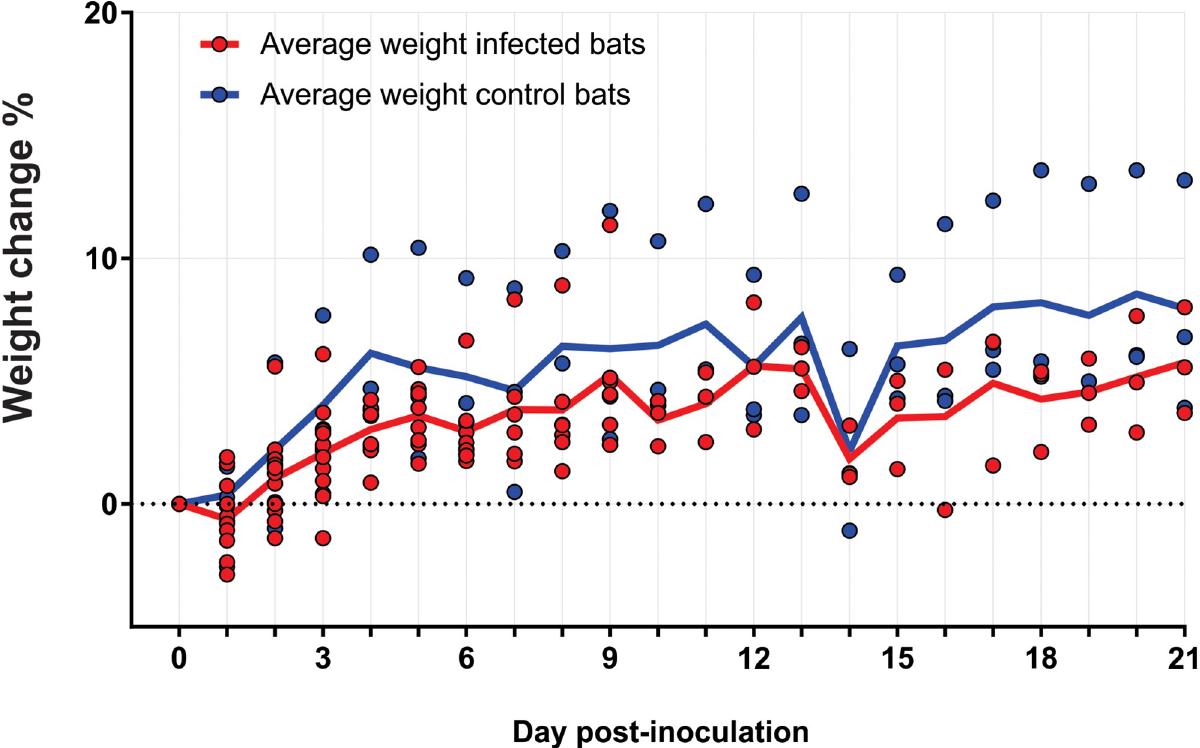
Fig 1. Percent weight change of inoculated and control bats. Percent weight change in grams comparison between experimental bats (n = 12; red) and negative control bats (n = 3; blue).